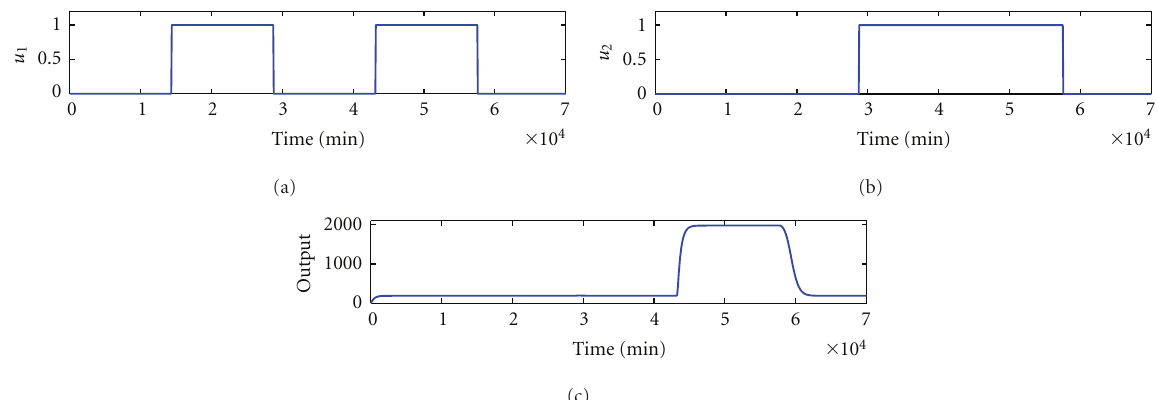
Figure 5: Desired transient behaviors of biological AND gate. The biological AND gate generates an output signal only when it gets biochemical signals from both of its inputs.